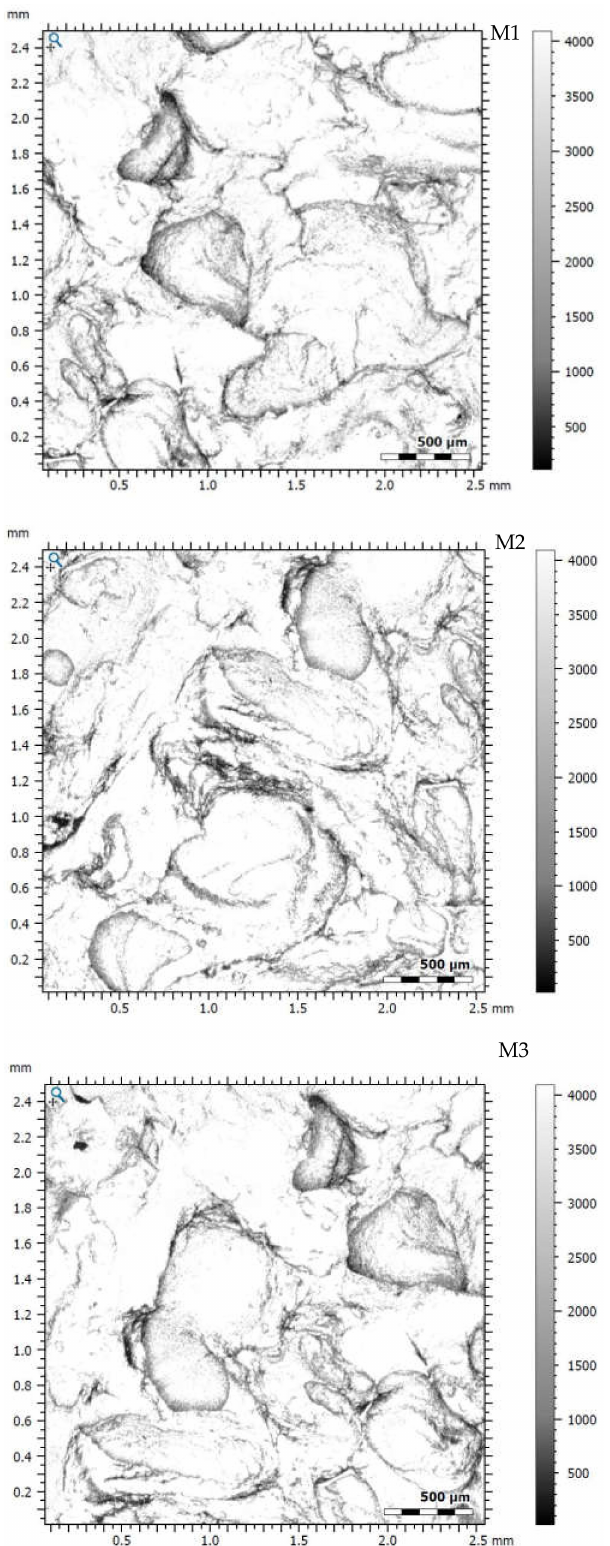
Figure 14. Confocal micrographs of the surface of carbon foam samples M1, M2,